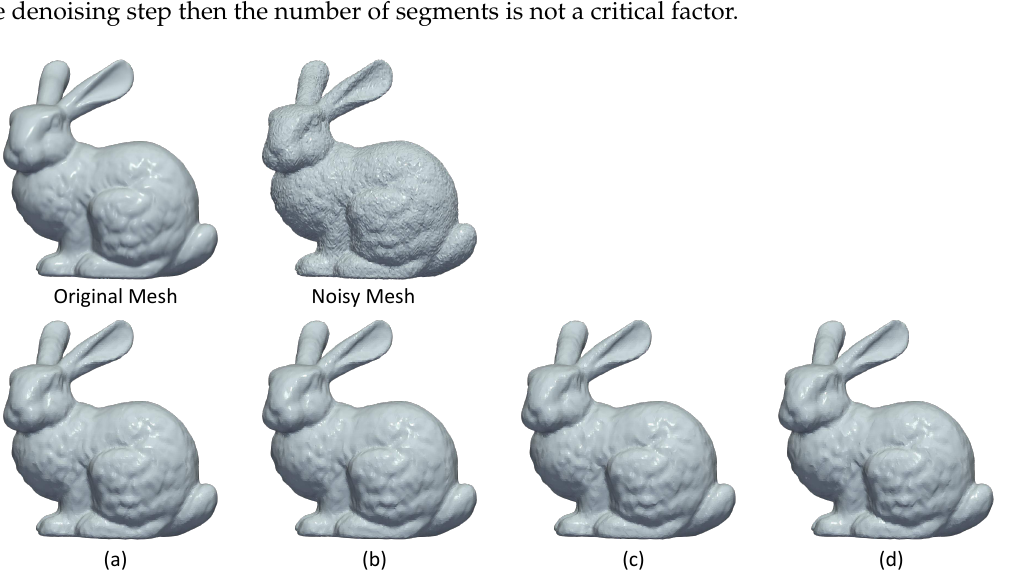
Figure 7. ( First line ) Original and Noisy mesh. ( Second line ) Coarse denoising meshes separated by Metis in ( a ) 25 submeshes, ( b ) 50 submeshes, ( c ) 70 submeshes, ( d ) 100